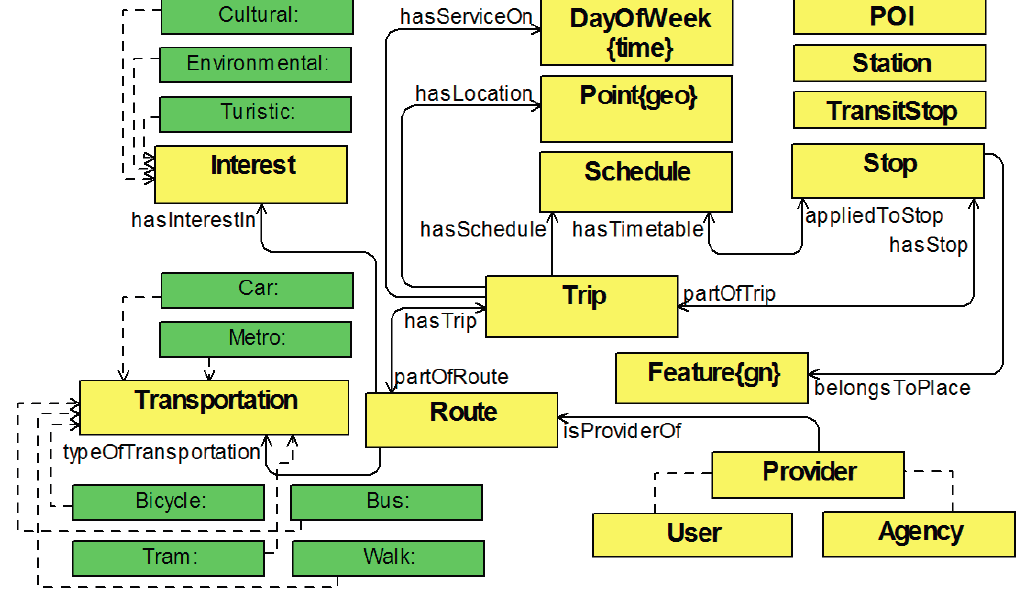
Figure 3. Multimodal Transport Ontology main concepts and